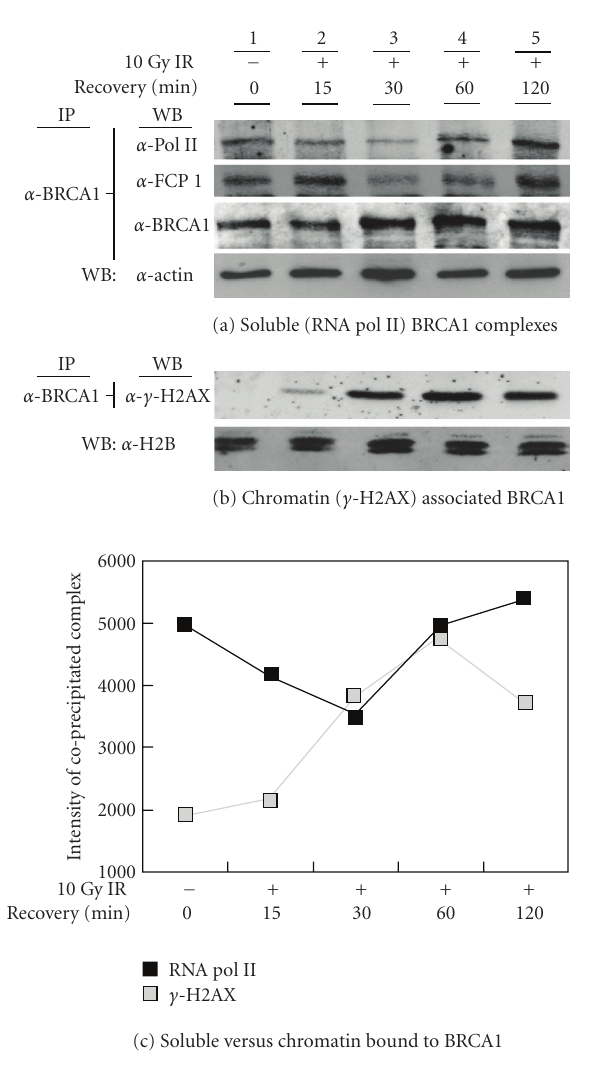
Figure 1: BRCA1 moves into a chromatin complex containing S 139 phosphorylated H2AX ( γ -H2AX) after DNA damage in vivo . HBL100 cells were exposed to 10Gy γ -irradiation (IR) or 4 μ M adriamycin then allowed to recover for the indicated time before isolation of protein complexes. (a) Nonchromatin (soluble) nuclear proteins from panel (a) were immunoprecipitated (IP) with antisera to BRCA1. Immunoprecipitates were treated with phosphatase (CIP) and immunoblotted (WB) using antibodies to RNA polymerase II (Pol II, 8WG16), FCP1, or BRCA1. 10% of the lysate was immunoblotted directly and probed for β -actin. (b) Total γ -H2AX and BRCA1-associated γ -H2AX were immunoprecipitated from the chromatin fraction of cells following IR. 10% of the chromatin fraction was blotted directly and probed for total H2B. (c) BRCA1 complexes identified in (a) and (b) were quantified and graphed as a function of time. (d) Chromatin- associated protein complexes were extracted (chromatin fraction) of cells exposed to IR as indicated. BRCA1 was immunoprecipitated (IP) from 90% of the chromatin extract, and immunoblots (WB) were probed with an antibody to γ -H2AX (S 139 phosphorylated H2AX). 10% of the chromatin fraction was blotted directly and probed for total H2A. (e) Cells were pretreated with wortmannin for 15 minutes prior to treatment with 4 μ M adriamycin for 1 hr. 90% of the chromatin fraction was immunoprecipitated (IP) with antibodies to either BRCA1 or γ -H2AX and blotted (WB) with an antibody to γ -H2AX. 10% of the chromatin fraction was blotted directly and probed for total